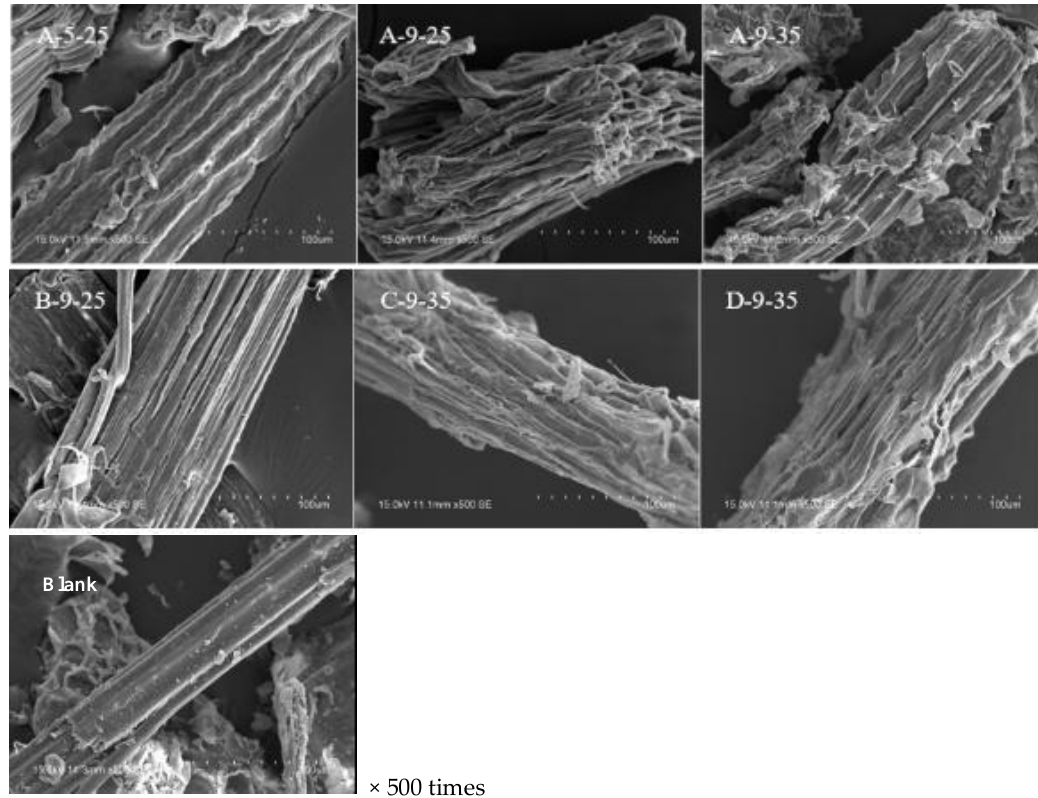
Figure 2. Scanning electron microscopy (SEM) images of samples before/after the combined pretreatment. A-5-25: 2% NaOH at 80 °C for 2 h and the ozone initial pH 5 for 25 min. A-9-25: 2% NaOH at 80 °C for 2 h and the ozone initial pH 9 for 25 min. A-9-35: 2% NaOH at 80 °C for 2 h and the ozone initial pH 9 for 35 min. B-9-25: 2% NaOH at 80 °C for 3 h and the ozone initial pH 9 for 25 min. C-9-35: 2% NaOH at 60 °C for 2 h and the ozone initial pH 9 for 35 min. D-9-35: 2% NaOH at 80 °C for 4 h and the ozone initial pH 9 for 35 min. Blank: untreated degreased stover. In comparison with A-9-25 and B-9-25, we could see that the stover surface of A-9-25 had more exposed, the cell wall was relaxed, the outer wall specific surface area increased, indicating that 2% NaOH was capable to expand the fiber structure than 4% NaOH. As a result, the enzymatic